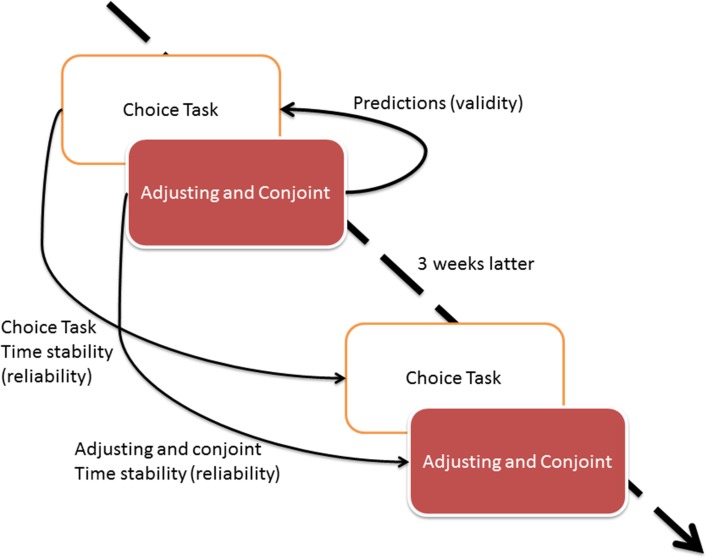
The Study 2 design.